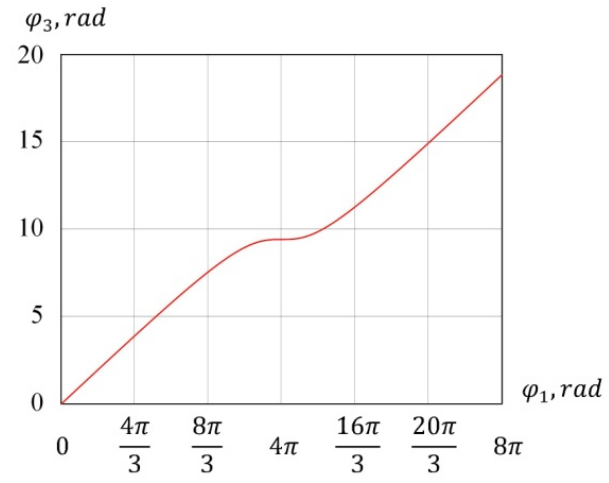
Figure 6. Graph of function 𝜑 (cid:2871) (𝜑 (cid:2869) ) .